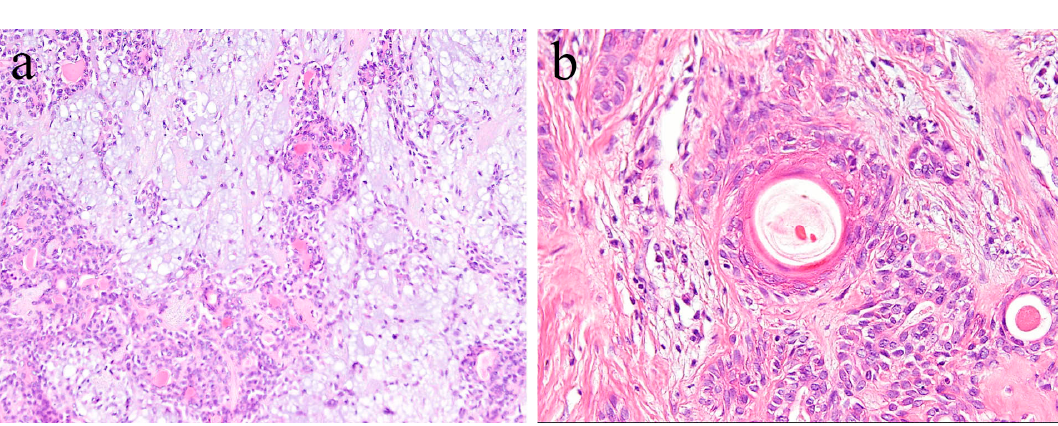
Figure 8. Histopathological features of pleomorphic adenoma (HE staining). ( a ) The tumor consists of solid sheet-like tumor nests and myxomatous mesenchymal parts. Magnification ×40. ( b ) Squamous metaplasia with keratin pearls located in the central region of the tumor nest. Magnification ×100.